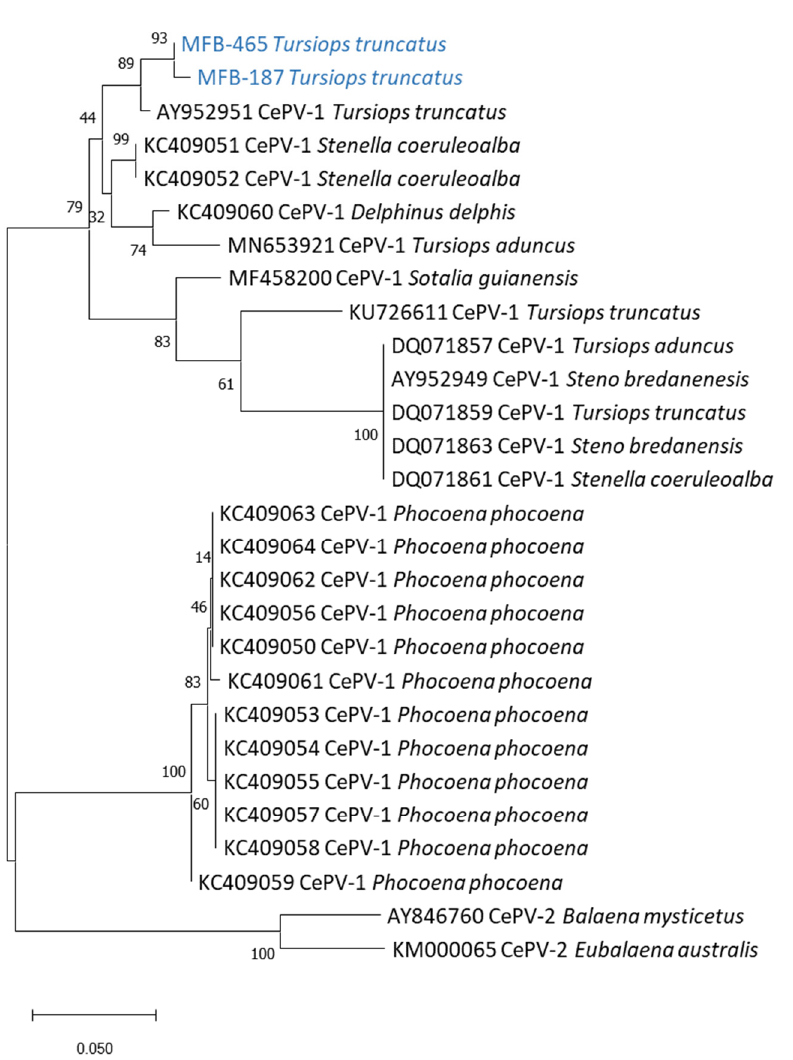
Figure 2. Phylogenetic analysis of CePV DNA topoisomerase nucleotide sequences obtained from tattoo skin lesions sampled in T. truncatus MFB-187 and MFB-465. The phylogenetic tree was created using maximum-likelihood methods based on the Tamura three-parameter model [27]. Numbers represent bootstrap values for each node, calculated with 5000 replicates. For sequences extracted from databases, sequence information corresponds to the virus GenBank accession number follow- ing the scientific name of the cetacean species in which the CePVs were detected. This analysis in- volved 28 nucleotide sequences. There was a total of 302 positions in the final dataset. Evolutionary analyses were conducted in MEGA X [28].